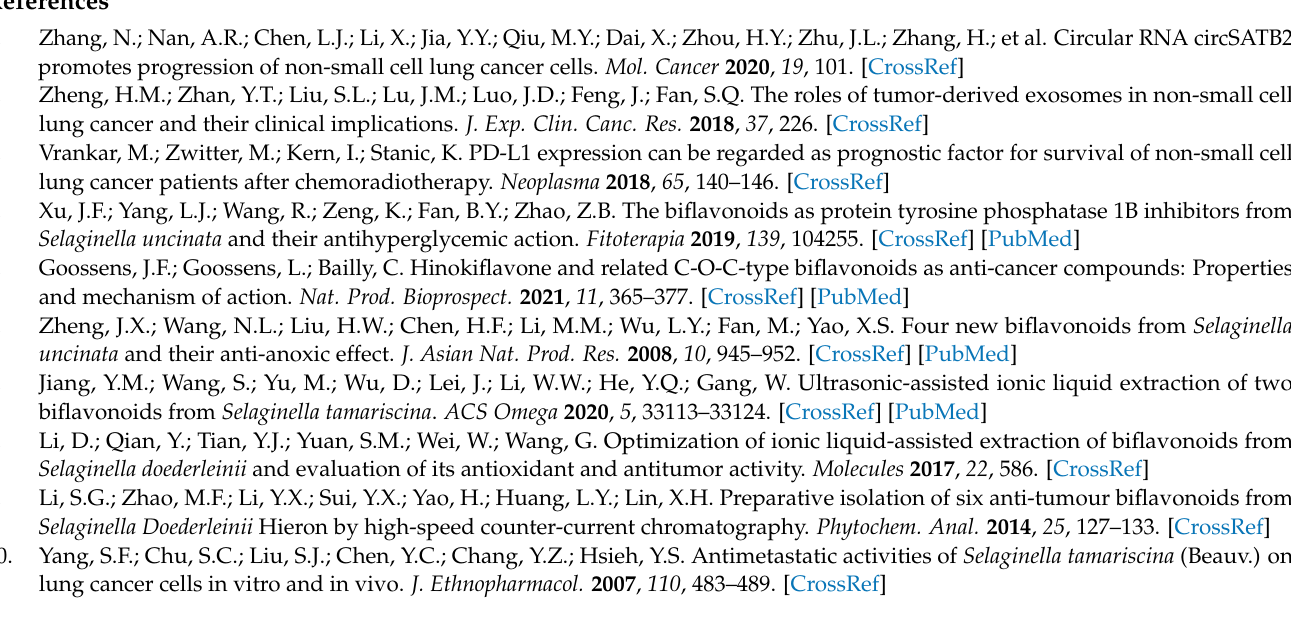
Figure S2: 1 H NMR spectrum (500 MHz) of 1 in DMSO- d 6 , Figure S3: 13 C NMR spectrum (125 MHz) of 1 in DMSO- d 6 , Figure S4: DEPT 135 spectrum (125 MHz) of 1 in DMSO- d 6 , Figure S5: 1 H- 1 H COSY spectrum of 1 in DMSO- d 6 , Figure S6: HSQC spectrum of 1 in DMSO- d 6 , Figure S7: HMBC spectrum of 1 in DMSO- d 6 , Figure S8: HRESIMS spectrum of 2 , Figure S9: 1 H NMR spectrum (500 MHz) of 2 in DMSO- d 6 , Figure S10: 13 C NMR spectrum (125 MHz) of 2 in DMSO- d 6 , Figure S11: DEPT 135 spectrum (125 MHz) of 2 in DMSO- d 6 , Figure S12: 1 H- 1 H COSY spectrum of 2 in DMSO- d 6 , Figure S13: HSQC spectrum of 2 in DMSO- d 6 , Figure S14: HMBC spectrum of 2 in DMSO- d 6 , Figure S15: HRESIMS spectrum of 3 , Figure S16: 1 H NMR spectrum (500 MHz) of 3 in DMSO- d 6 , Figure S17: 13 C NMR spectrum (125 MHz) of 3 in DMSO- d 6 , Figure S18: DEPT 135 spectrum (125 MHz) of 3 in DMSO- d 6 , Figure S19: 1 H- 1 H COSY spectrum of 3 in DMSO- d 6 , Figure S20: HSQC spectrum of 3 in DMSO- d 6 , Figure S21: HMBC spectrum of 3 in DMSO- d 6 , Figure S22: HRESIMS spectrum of 4 , Figure S23: 1 H NMR spectrum (800 MHz) of 4 in DMSO- d 6 , Figure S24: 13 C NMR spectrum (200 MHz) of 4 in DMSO- d 6 , Figure S25: DEPT 135 spectrum (125 MHz) of 4 in DMSO- d 6 , Figure S26: 1 H- 1 H COSY spectrum of 4 in DMSO- d 6 , Figure S27: HSQC spectrum of 4 in DMSO- d 6 , Figure S28: HMBC spectrum of 4 in DMSO- d 6 , Figure S29: Effects of compounds 1–3 on expression of caspase-3/cleaved